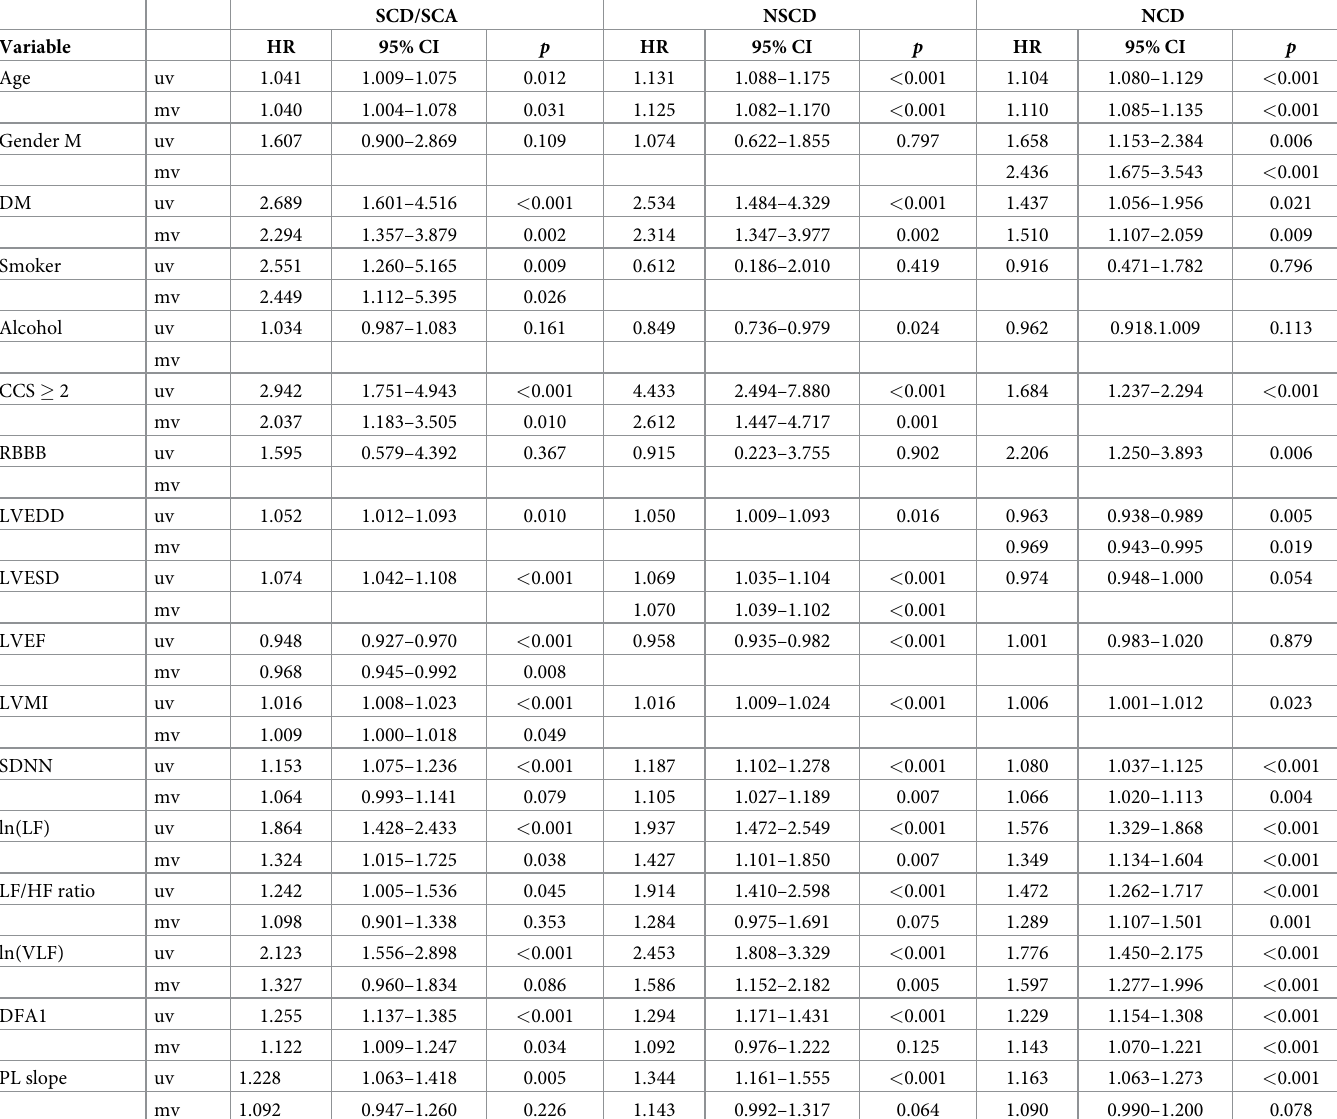
Table 2. Univariate and multivariate predictors of sudden cardiac death or sudden cardiac arrest, non-sudden cardiac death and non-cardiac